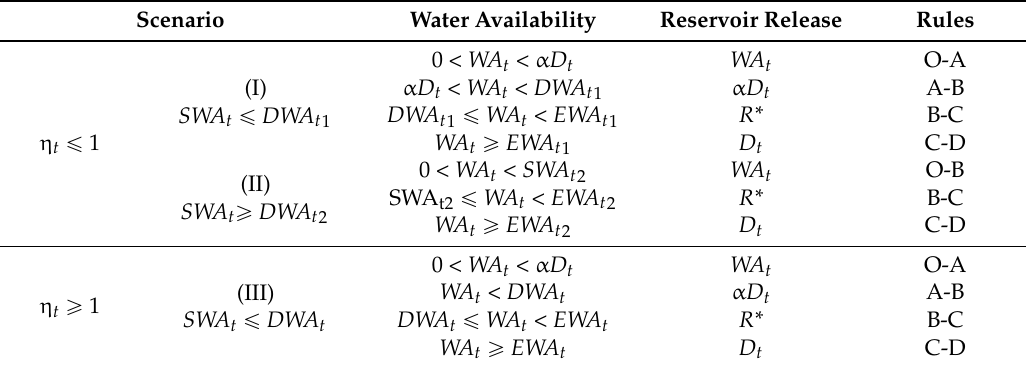
Table 1. The three situations of the hedging rules.